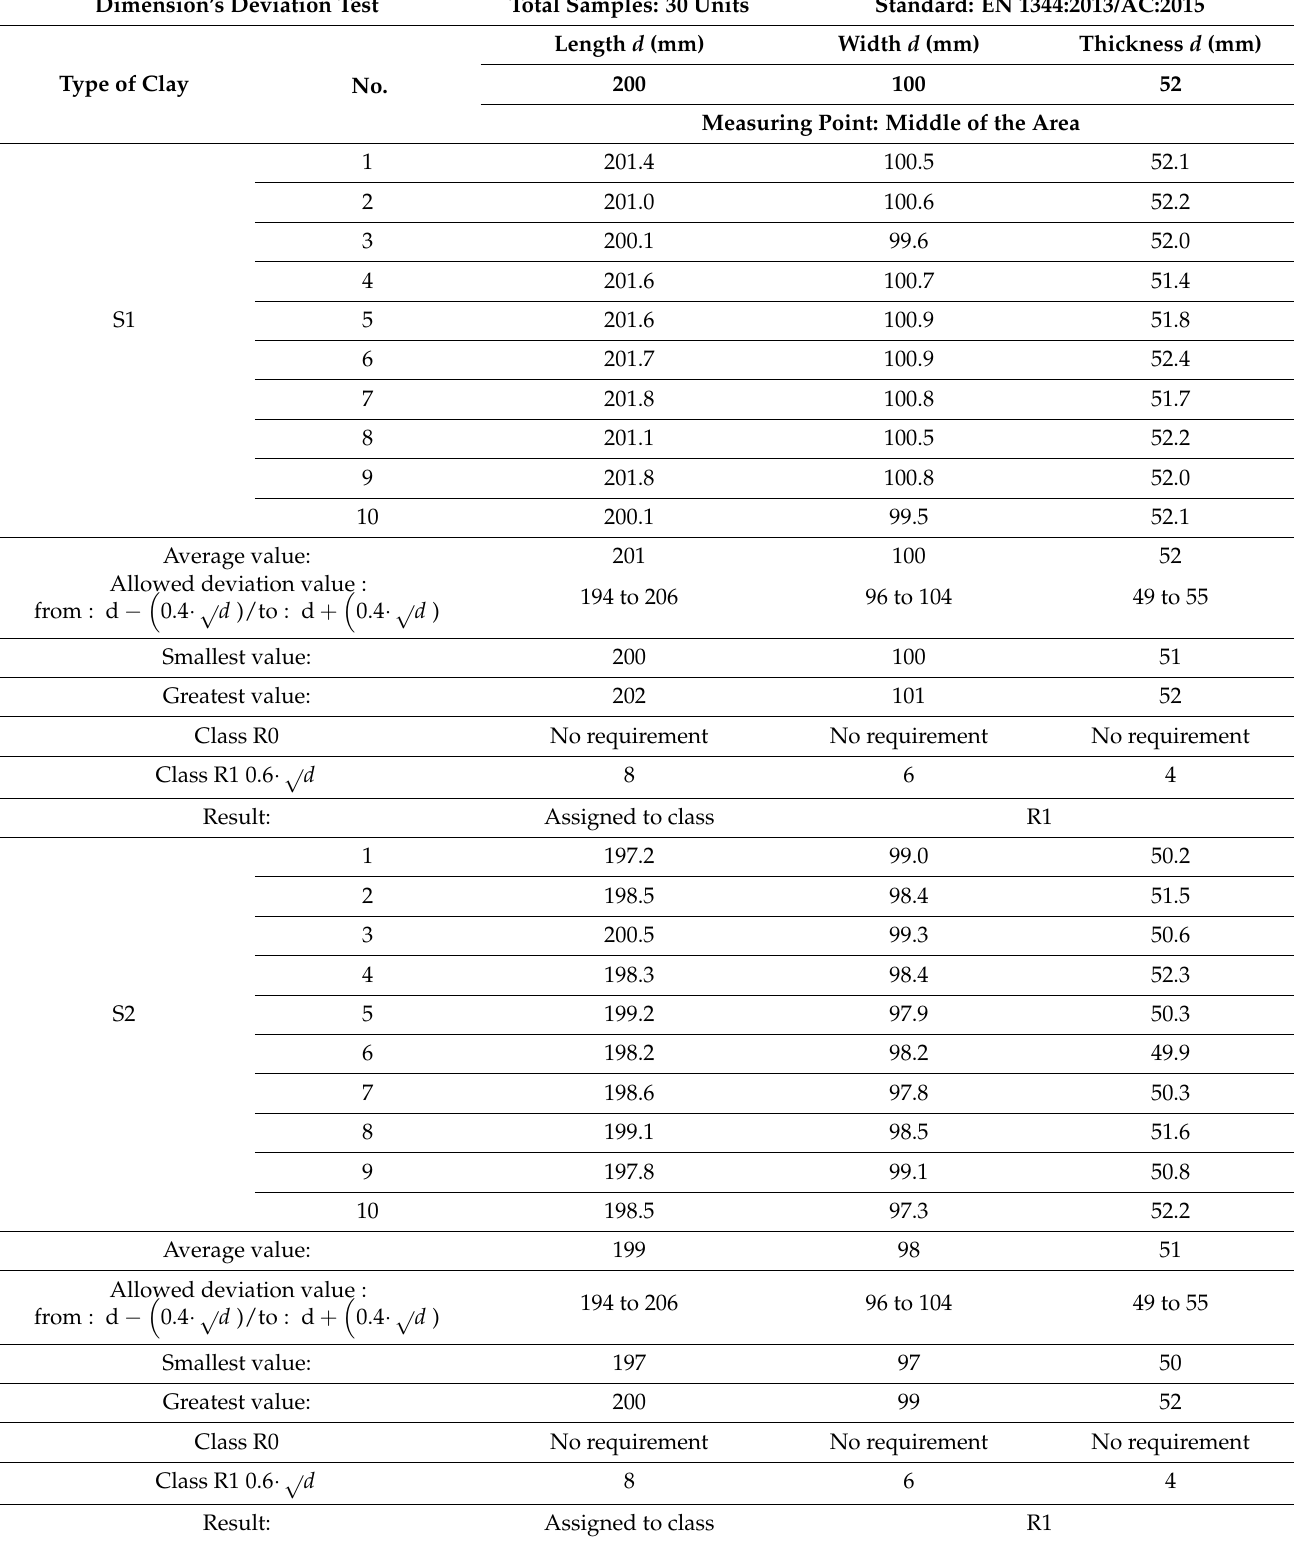
Table 2. Assessment of dimensional